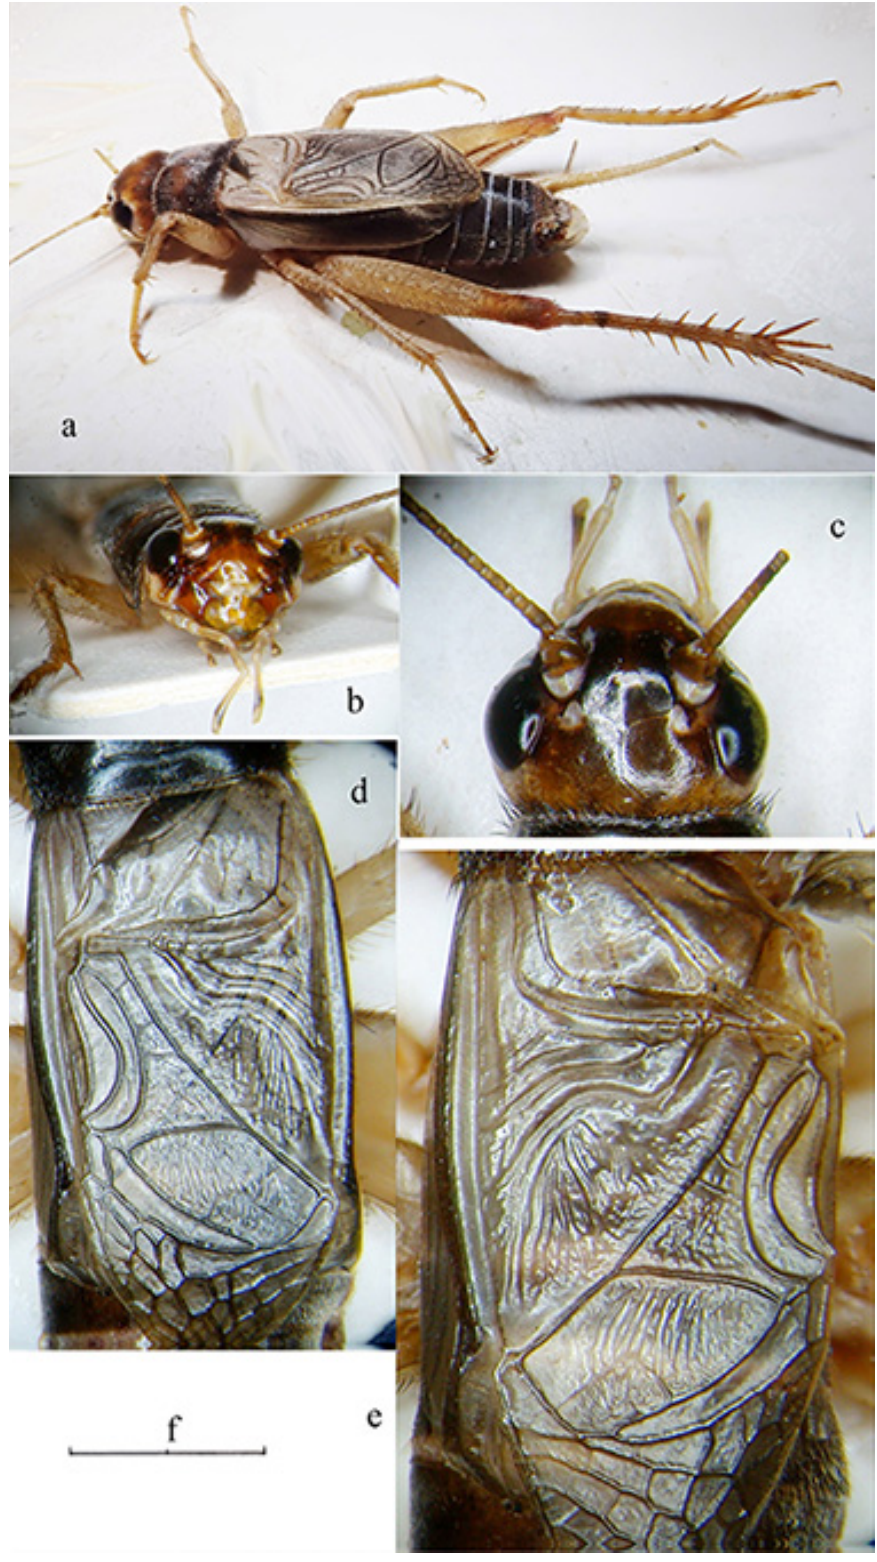
Figure 5. Acheta pantescus n. sp. male adult from the lighthouse of Punta Limarsi, Pantelleria. ( a ) lateral view; ( b ) head in frontal view; ( c ) head in dorsal view; ( d ) detail of male right tegmen; ( e ) detail of male left tegmen; ( f ) scale (a: 9.0 mm; b: 4.5 mm; c: 3.2 mm; d: 2.3 mm; e: 2.7 mm).